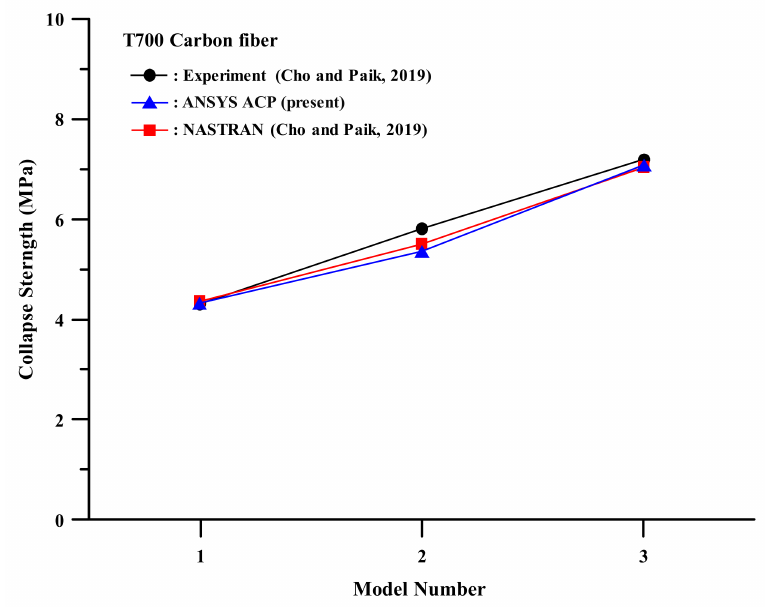
Figure 7. Comparison of collapse strength obtained for composite material. Table 6. Summary of collapse strength obtained for the composite material. Collapse Strength (MPa) Finite Elemetn No. [14]Experiment